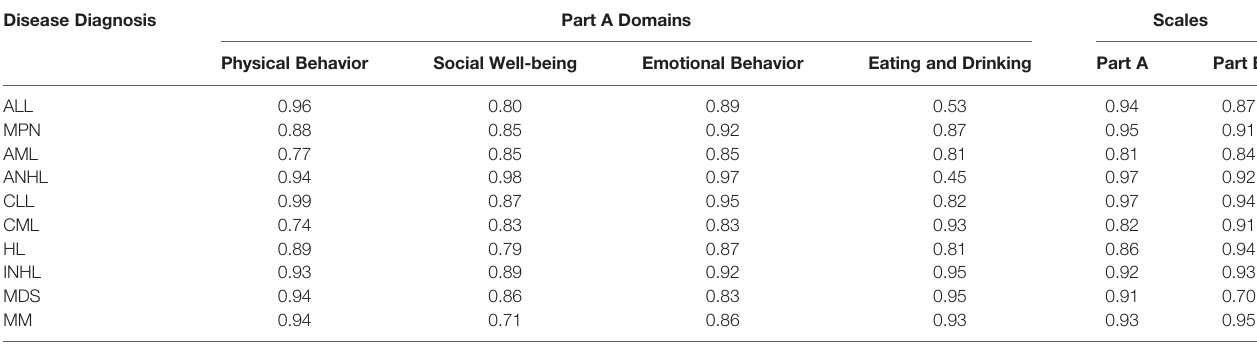
ALL, acute lymphoid leukemia; AML, acute myeloid leukemia; CLL, chronic lymphoid leukaemia; CML, chronic myeloid leukemia; MM, multiple myeloma; INHL, indolent non-Hodgkin lymphoma; ANHL, aggressive non-Hodgkin lymphoma; HL, Hodgkin lymphoma; MDS, myelodysplastic syndrome; MPN, myeloproliferative neoplasm.